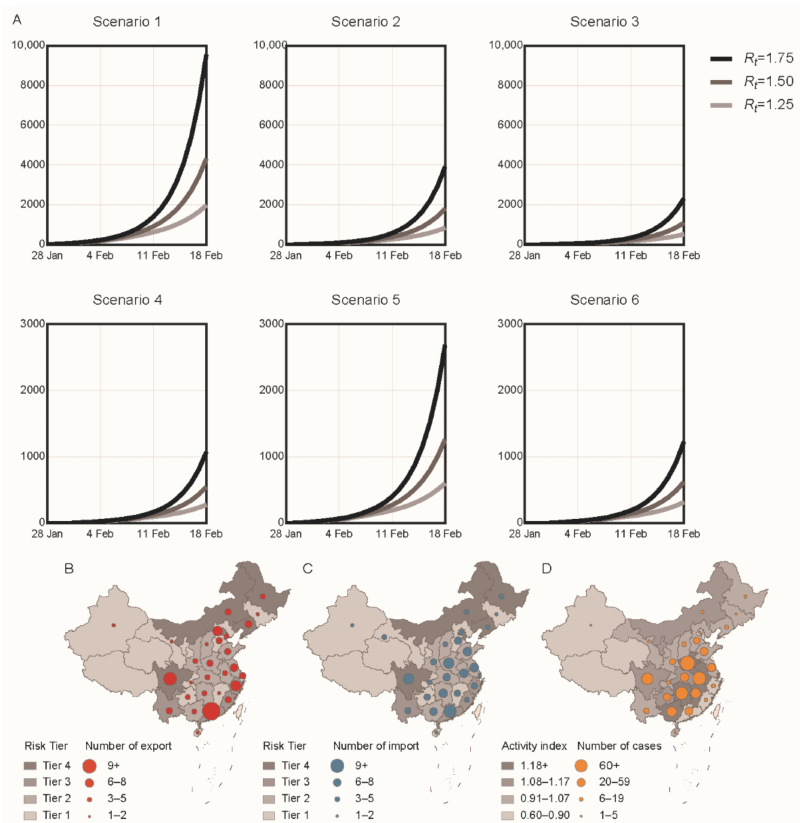
Figure 2. Simulated epidemic in mainland China after the Spring Festival period by different scenarios. ( A ) We forecast the total number of cases (vertical axis) in mainland China after the Spring Festival period by different scenarios (panels). Different grayscale lines represent different values of R t . ( B – D ) Number of exported cases, imported cases, and locally transmitted cases in 31 provincial- level regions by scenario 6. The grayscale of the map represents the risk tier and population activity index in each region. The circles represent the number of cases. R t —effective reproduction